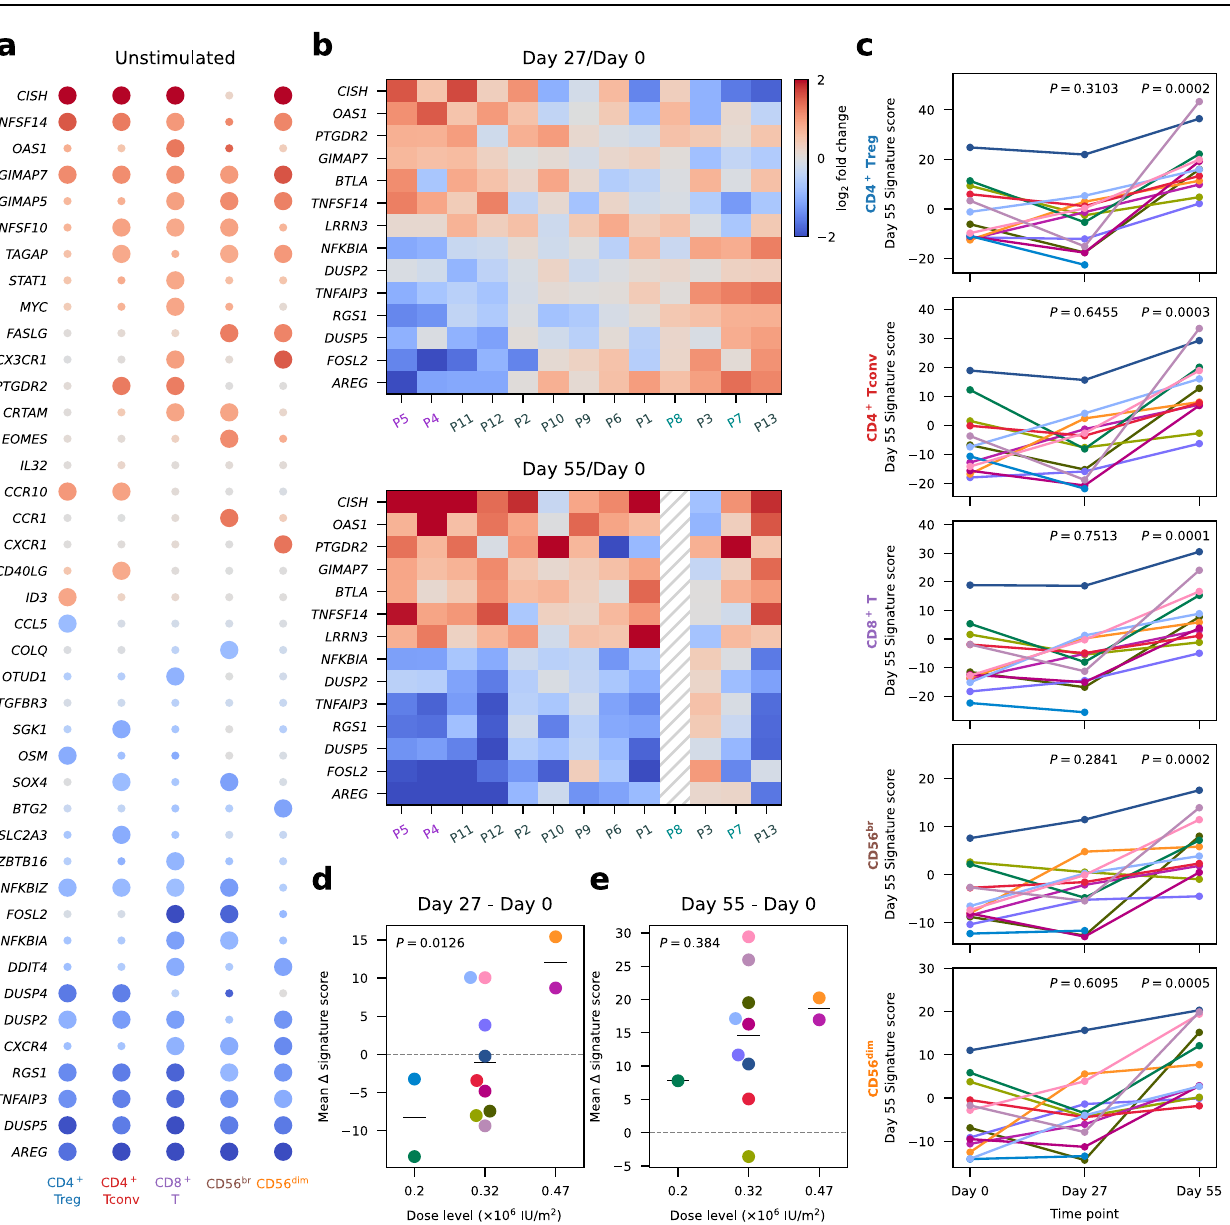
0.32 (grey), 0.47 (purple). c Day 55 signature scores by participant for each time point and cell type. Each participant is represented by a different colour. P values werecalculatedusingatwo-tailedpaired t testcomparingDay27orDay55withDay 0, respectively. d , e Variation in the mean expression scores of Day 55 signature genesacrossthe fi vemajorcelltypes(mean Δ signaturescore)betweenDay27and Day0 ( d ) and between Day 55 and Day0 ( e ) for each participant. Participants were strati fi ed by IL-2 dose. P values were calculated using linear regression, without multiple-comparison adjustments. In ( d and e ), average values of the Day 55 sig- nature in all fi ve cell types are shown for each participant. n =13 participants. Source data for ( a – e ) are provided as a Source Data fi